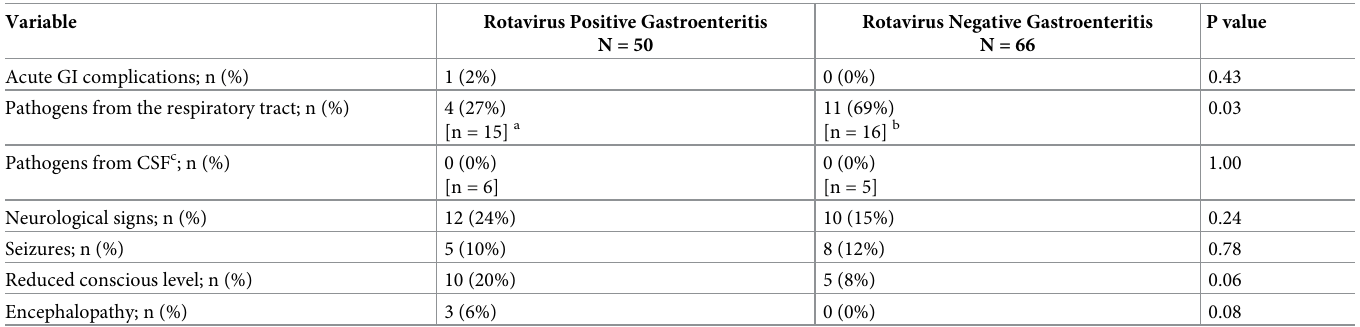
Table 4. Complications in children with rotavirus-positive and rotavirus-negative